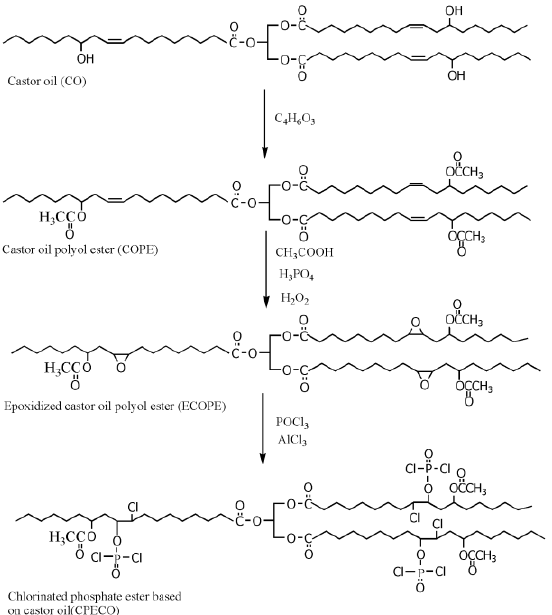
Figure 12. Synthesis of castor oil phosphate ester.